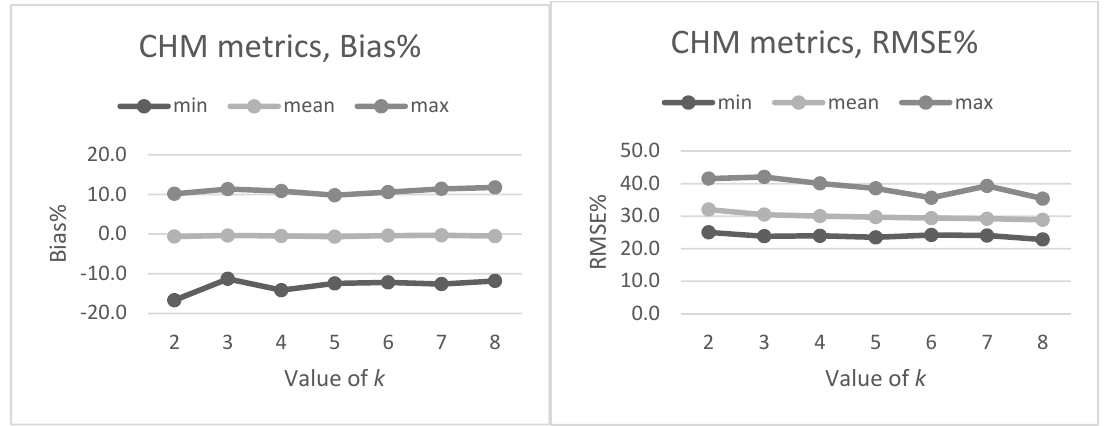
Figure A2. The effect of k -value to the estimated bias% ( right ) and RMSE% ( left ) of totalB using CHM metrics as predictor variables.